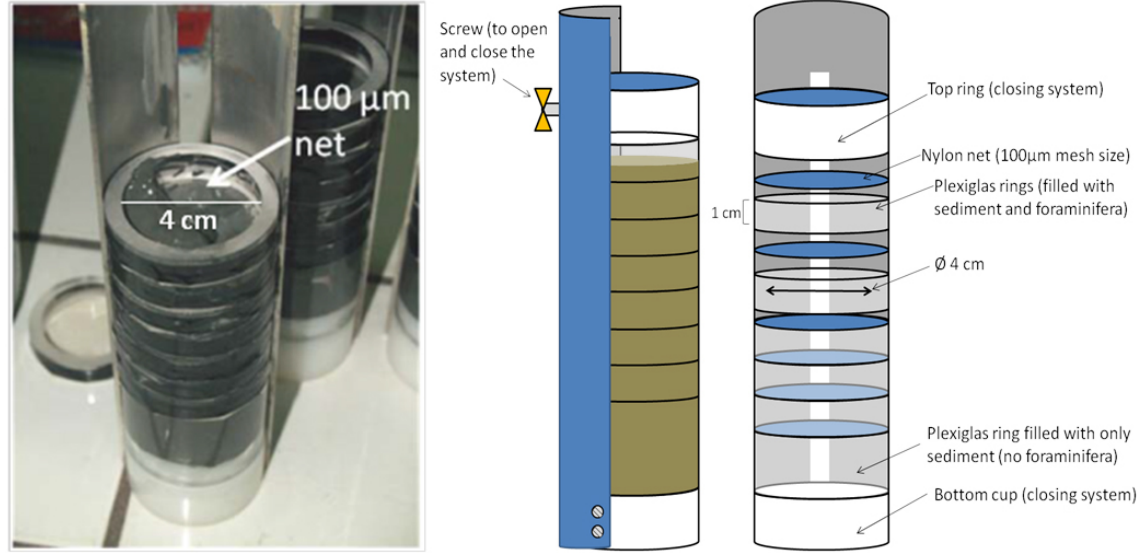
Figure 1. Experimental cores. Picture showing the filling up of the cores with sieved sediment (left) and the scheme of the experimental cores